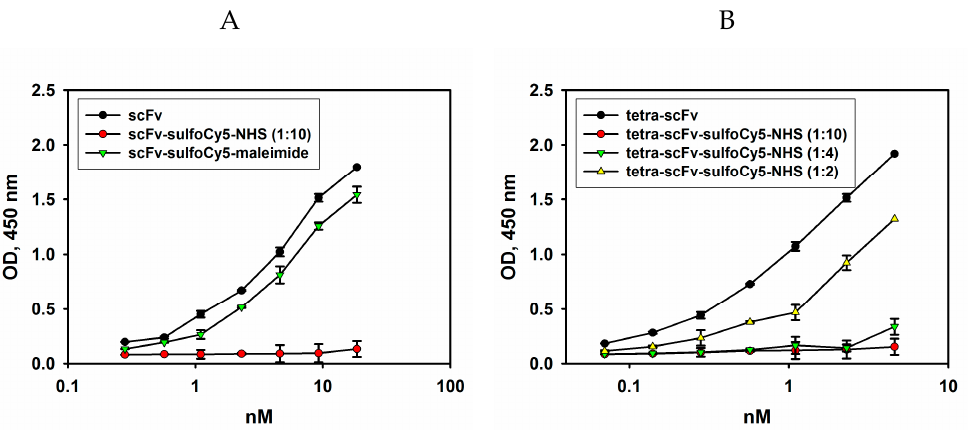
Figure 8. Direct ELISA. Ganglioside GD2 was adsorbed on the plate; serial dilutions of scFv fragments labelled with Sulfo-Cy5-NHS (protein:dye ratio = 1:10) or Sulfo-Cy5-maleimide ( A ), or serial dilutions of tetra-scFv fragments labelled with Sulfo-Cy5-NHS (protein:dye ratios = 1:10, 1:4, or 1:2) ( B ) were added to the wells. After incubation with HRP-labelled anti-FLAG antibodies (1:6000), the reaction was developed by Ultra TMB-ELISA Substrate Solution. Data are represented as mean ± SEM. As shown in Figure 8, the use of high concentrations of Sulfo-Cy5-NHS dye resulted in the loss of binding of non-pegylated scFv and tetra-scFv fragments to ganglioside GD2, and the same patterns were characteristic of other pegylated fragments (data not shown). For this reason, the ratios of Sulfo- Cy5-NHS dye and pegylated scFv fragments introduced into the reaction were optimized in such a way as to retain approximately 80% of antigen-binding activity of the non-labelled scFv-PEG conjugates (Figure 8B). At the same time, the original non-pegylated scFv fragments contain the C- terminal free cysteine, which was employed to attach a different dye, Sulfo-Cyanine5-maleimide, by